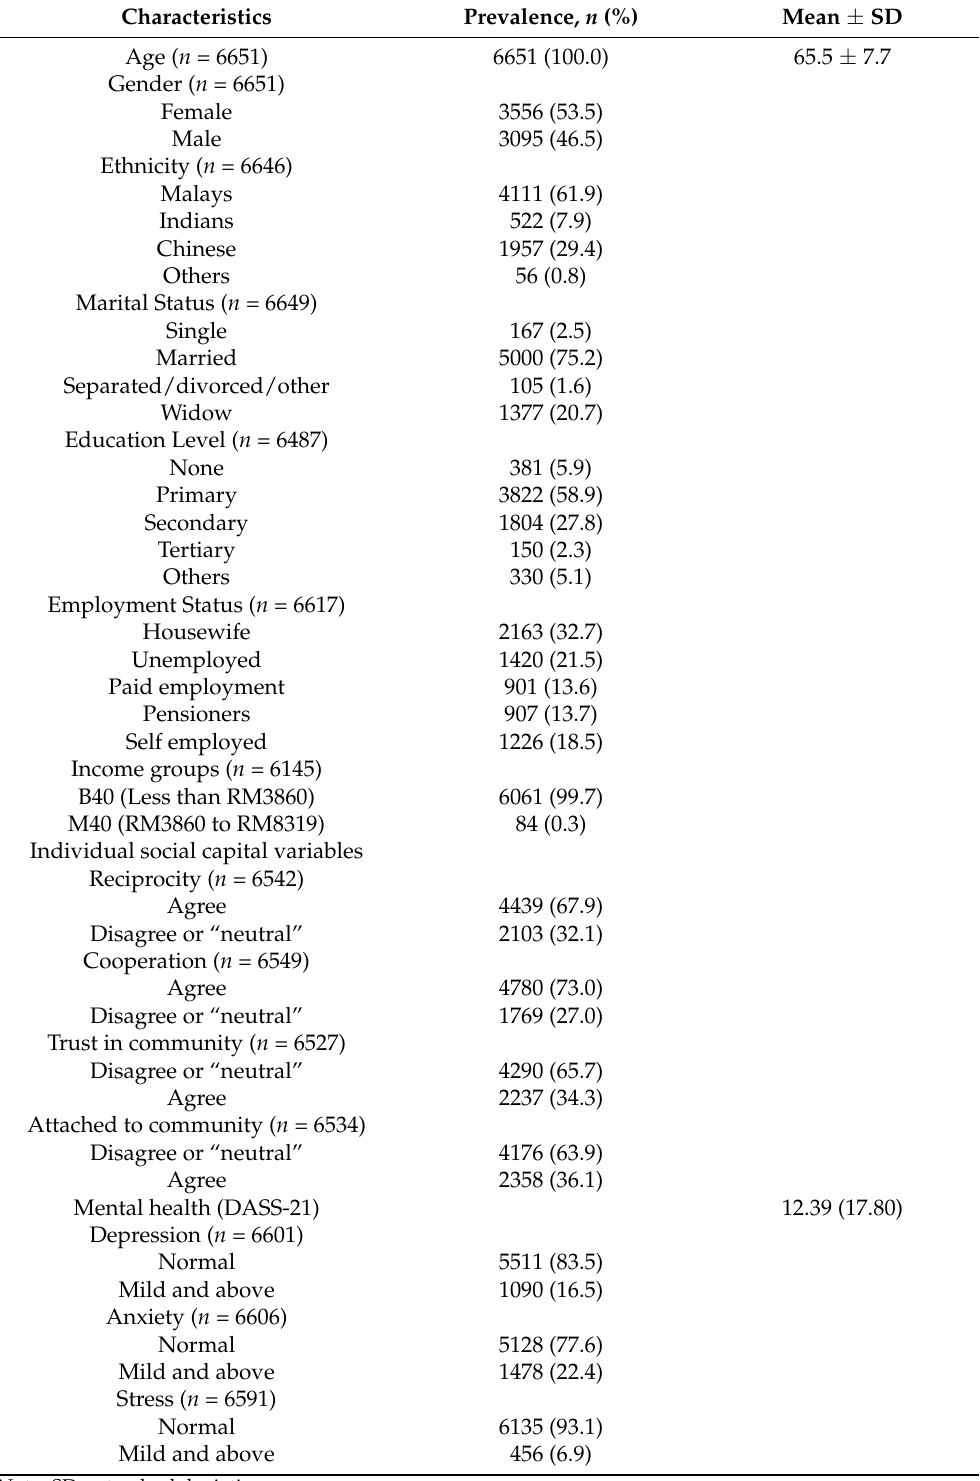
Table 1. Sample characteristics of the semi-urban and rural community ( n =